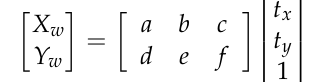
where ( a , b , c , d , e , f ) are 2D affine-transformation parameters. coordinates of the corresponding model triangle are put into Equation (2). After